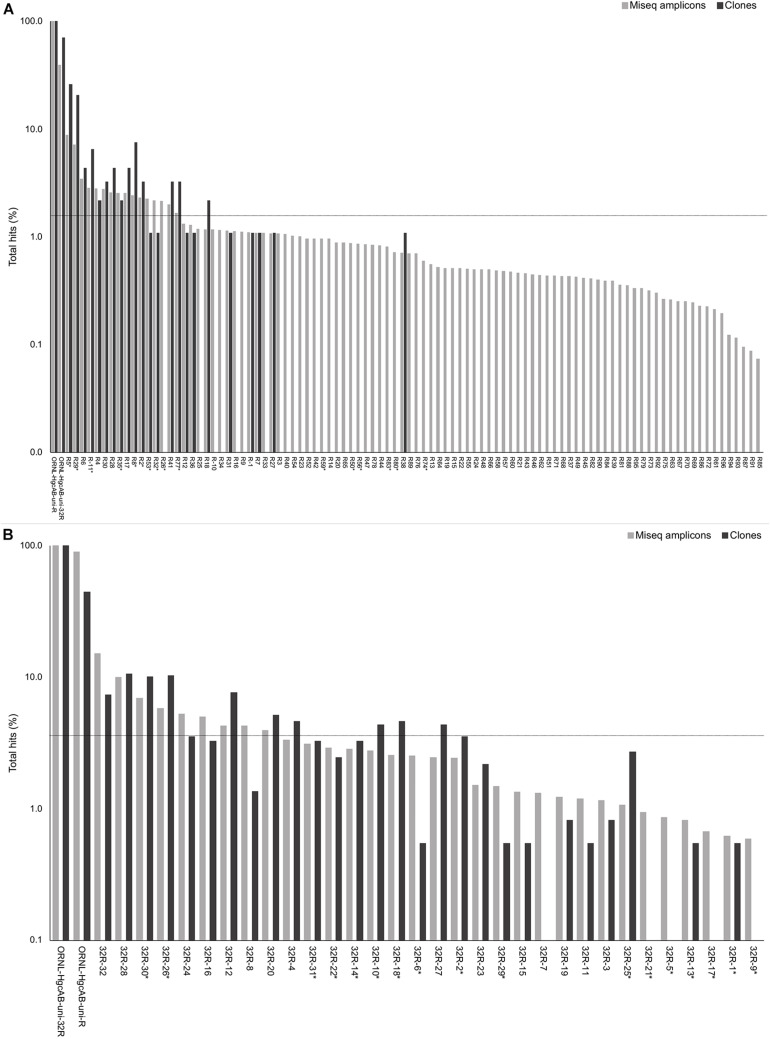
Percent occurrence of each 96-degenerate reverse (top; ORNL-HgcAB-uni-R) and 32-degenerate reverse primer (bottom; ORNL-HgcAB-uni-32R) oligonucleotide sequence in the environmental clone hgcAB sequences and Miseq amplicons. Primers are listed in Supplementary Table S2. Matches to each broad-range reverse primer (ORNL-HgcAB-uni-R, ORNL-HgcAB-uni-32R) are shown for each set of clone and amplicon sequences amplified with the ORNL-HgcAB-uni-R (A) and ORNL-HgcAB-uni-32R (B). Oligonucleotide sequences shared between each reverse primer are indicated with asterisk (∗). Reverse primer sequences were found in 95 clones (A) and 369 clones (B), and 210, 362 (A) and 233, 934 (B) amplicon reads. Data is shown on a log scale. Dashed line indicates equal distribution of reverse primer sequences across amplicon sequences: (A) 1.04%, (B) 3.13%. Ordered by decreasing abundance in Miseq amplicon libraries.